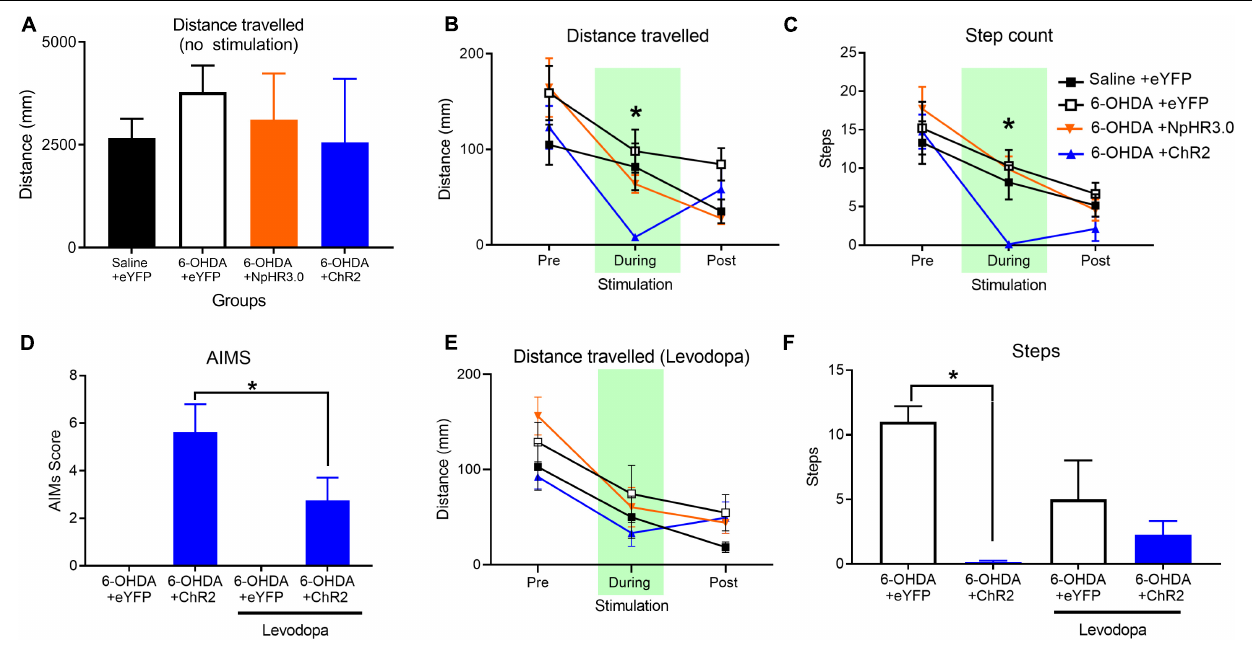
FIGURE 4 | Changes in locomotor in PD rodent model upon STN stimulation and Levodopa administration. No significant effect on groups on distance travelled during no optogenetic manipulation (A) . A 30 s open field test involving 10 s pre-, during and post-stimulation periods demonstrated a significant decline in distance (B) and step count (C) . Levodopa administration significantly reduced abnormal involuntary movement (AIMS) (D) rescues impact on distance travelled (E) significantly lower step count (F) . Data is expressed as mean ± SEM, * p <